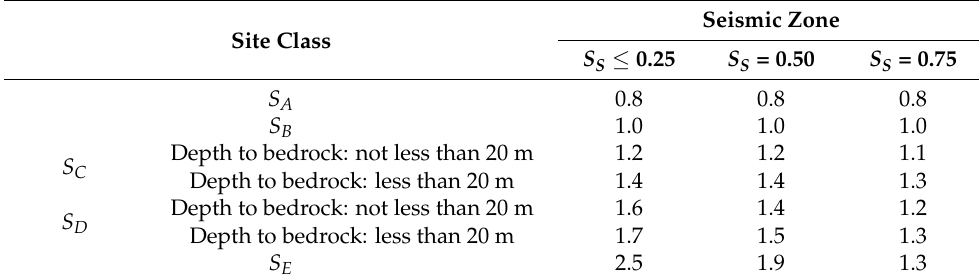
Figure 10. Design acceleration response spectrum in Korea. Table 2. Soil amplification parameter at short-period, F a .